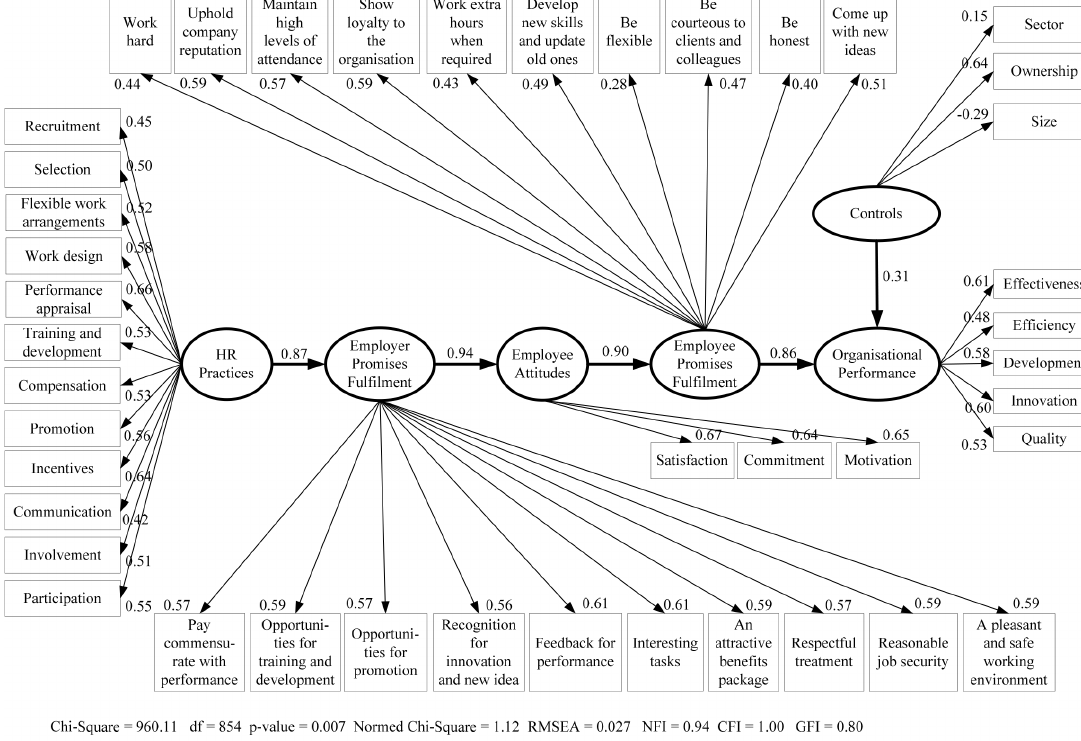
Figure 2. Estimation results of the hypothesized model for year 2008